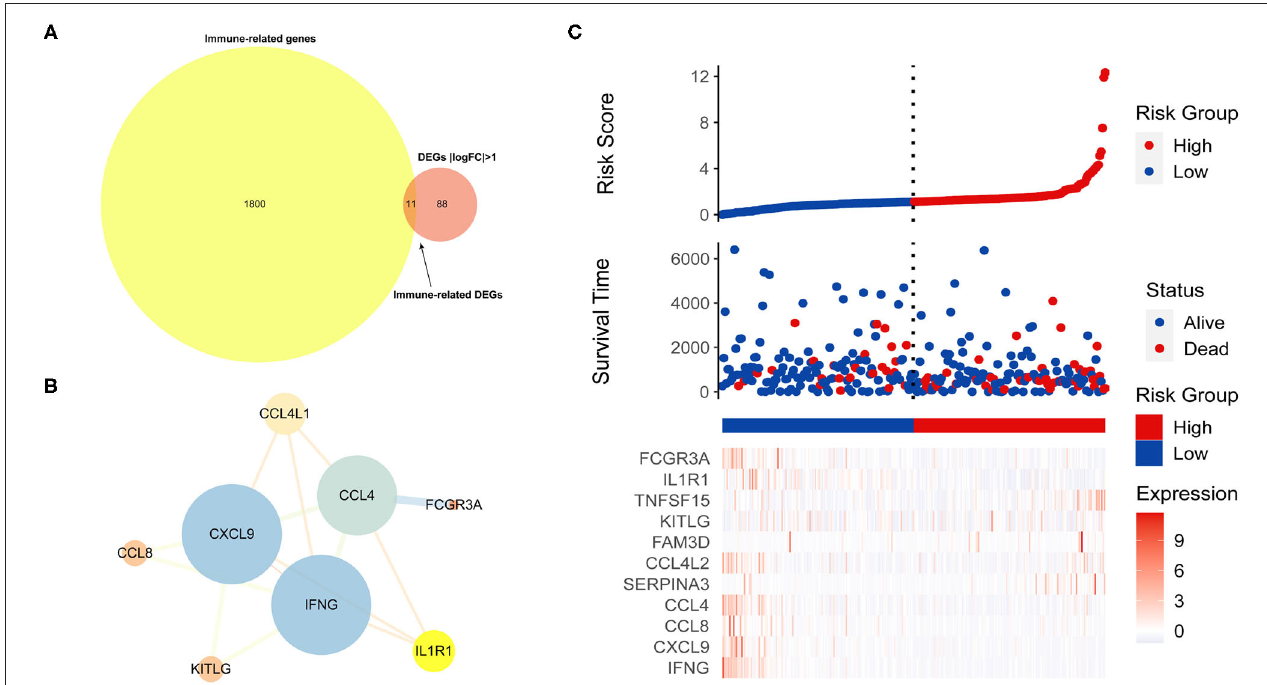
FIGURE 5 | Identification of immune-related differentially expressed genes related to prognosis (PIRDEGs). (A) Venn plot displaying the 11 IRDEGs. (B) The PPI network of IRDEGs. (C) The graph presents the risk score distribution of patients, survival status scatter plots of patients, and expression levels of risk genes.